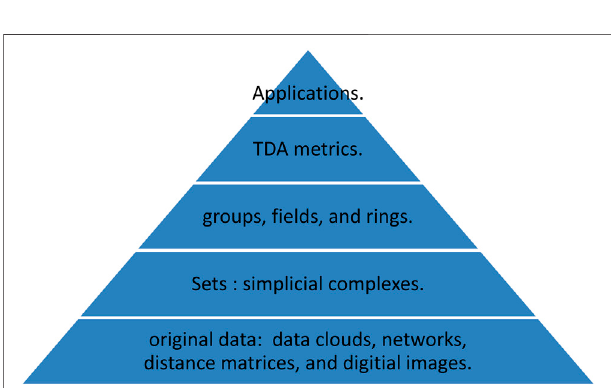
FIGURE 4 | A pyramid illustrating sequential procedures of how we make use of the original data and convert them into different forms of sets, i.e. simplicial complexes, and to groups, fi elds, and rings. At the topmost stage, we can use them for various applications, such as ML, and statistical learning,